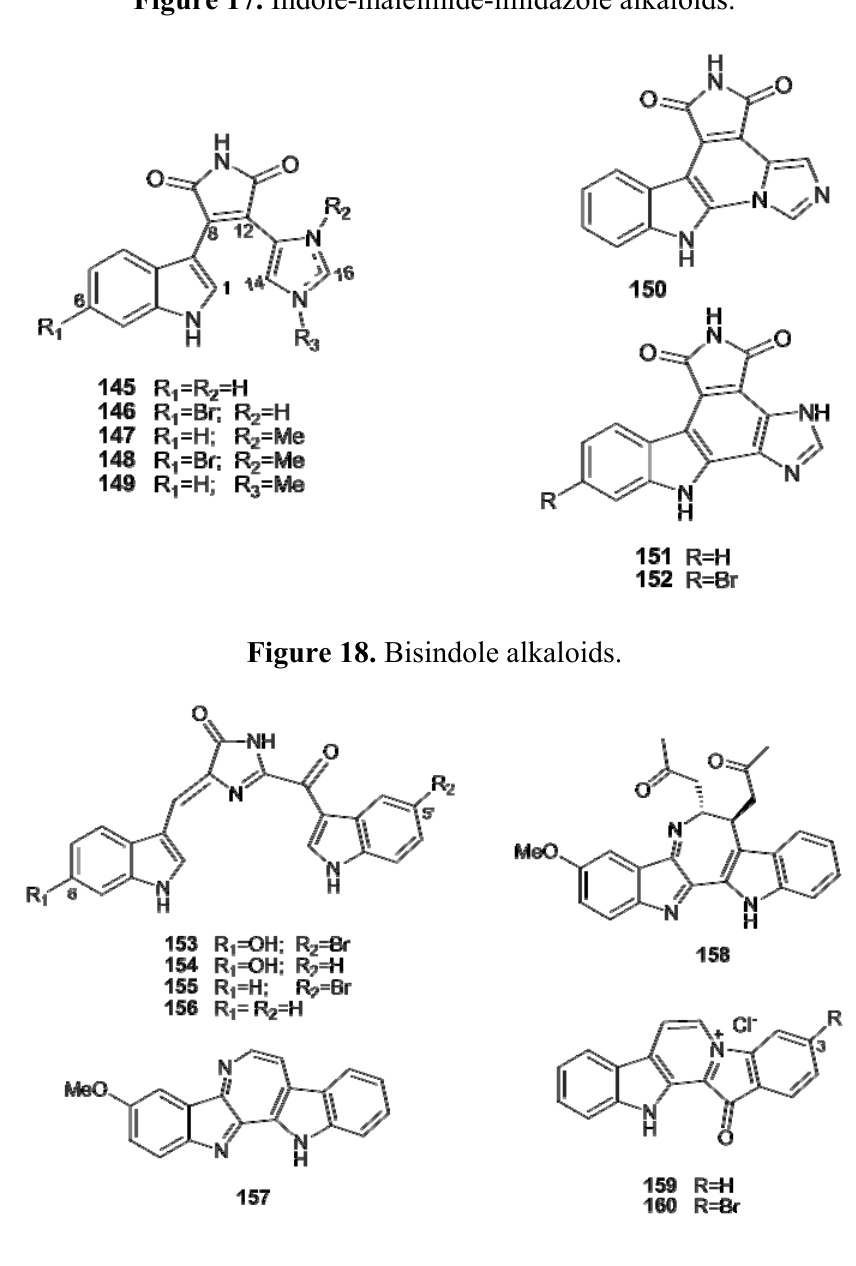
Figure 17. Indole-maleimide-imidazole alkaloids.